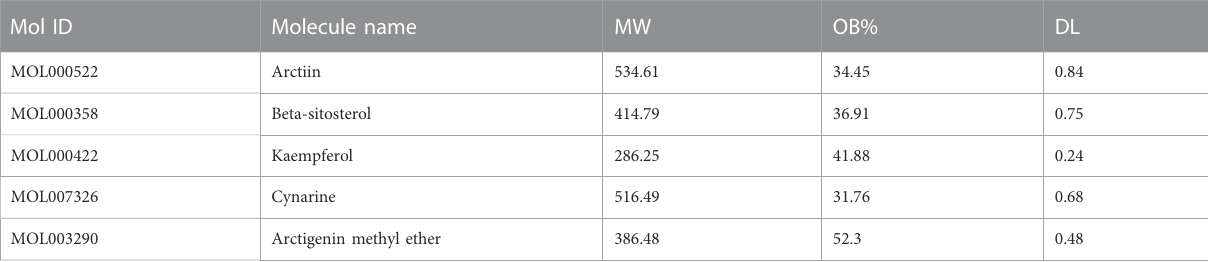
TABLE 3 The top fi ve potential active components of Fructus Arctii . Mol